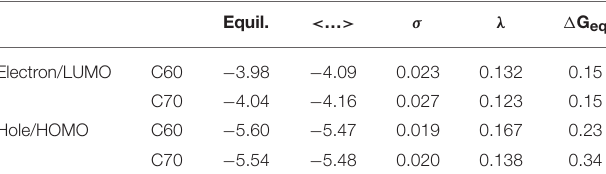
TABLE 1 | HOMO and LUMO energies at the equilibrium geometry (“Equil.”), their expectation values over MD trajectories (“ < … > ”), standard deviations of HOMO and LUMO distributions over MD trajectories (“ σ ”) as well as reorganization energies λ and driving forces 1 G eq for electron and hole transport in C60 and C70.